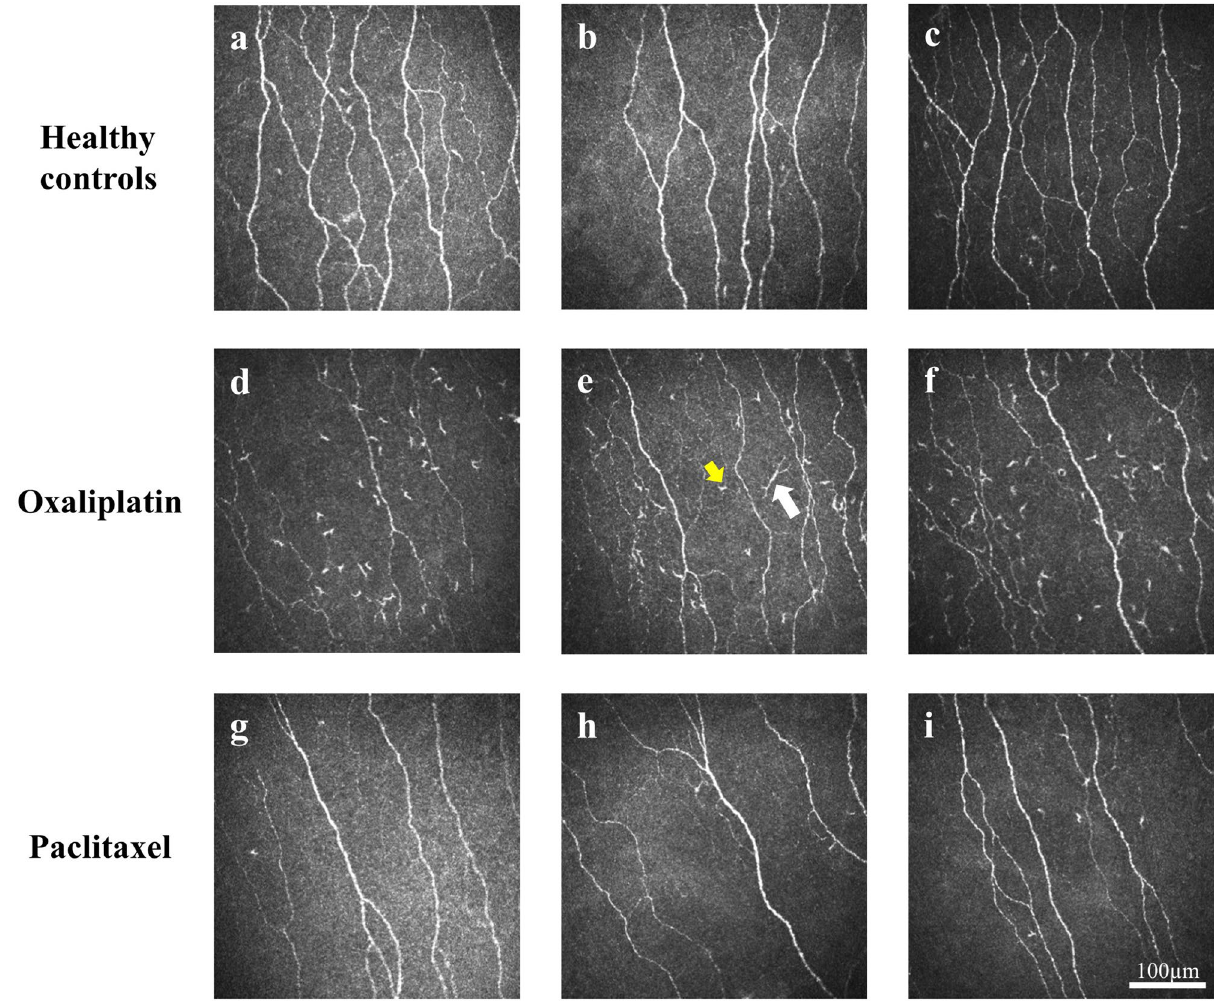
Figure 1. Representative in-vivo corneal confocal microscopy images. Images shown are in healthy controls ( a–c ), oxaliplatin-treated ( d–f ) and paclitaxel-treated ( g–i ) patients. Immature dendritic cells (ImDC, yellow arrow in e ) and mature dendritic cells (MDC, white arrow in e ) are